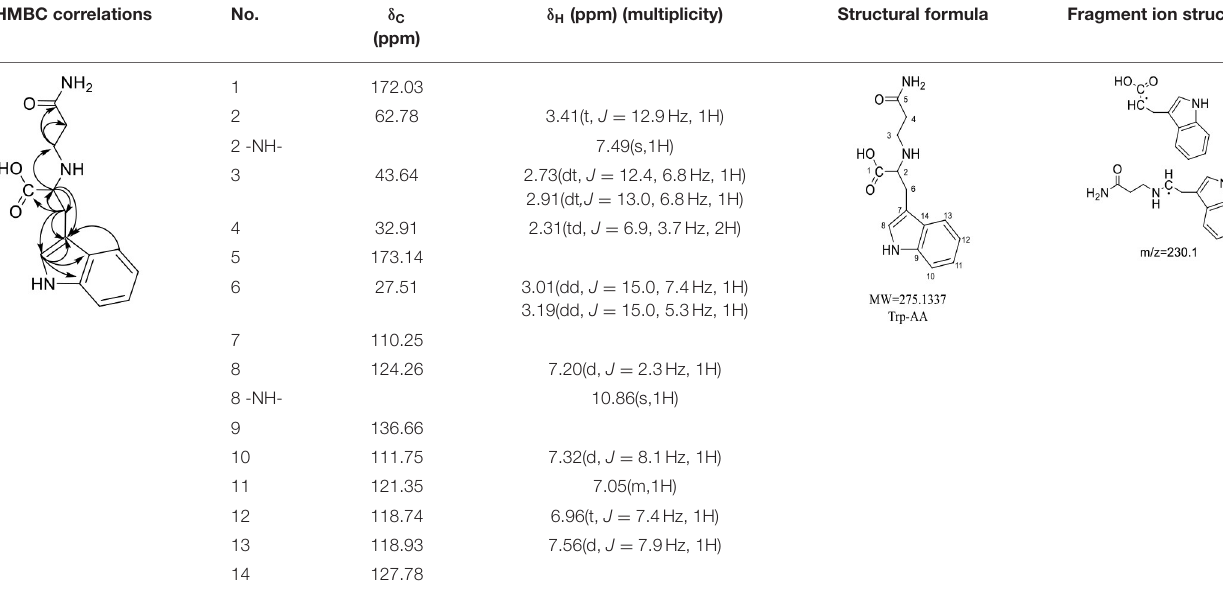
TABLE 5 | NMR spectra data of Trp-AA measured in DMSO-d 6 .